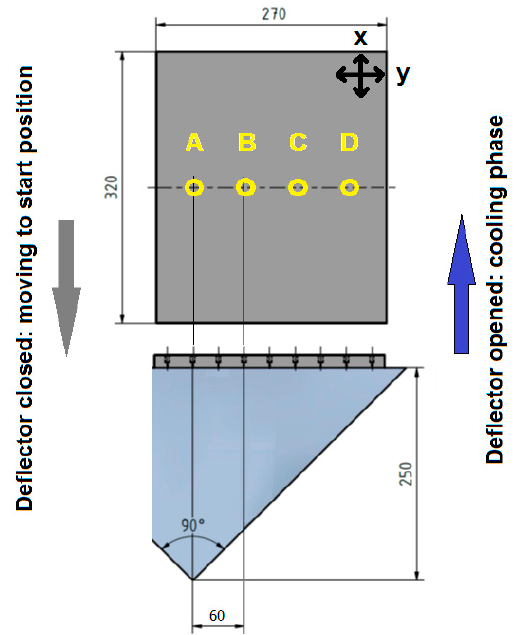
Figure 1. Scheme of the measurement, all data are available in points A–D. (Dimensions are in mm).